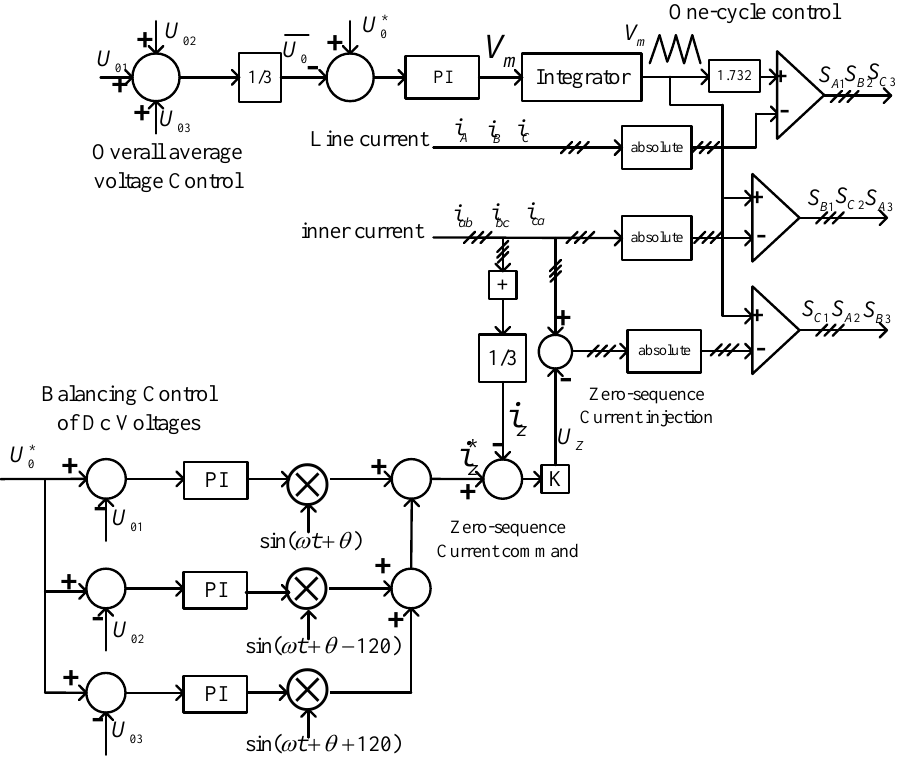
Figure 8. The system overall control.